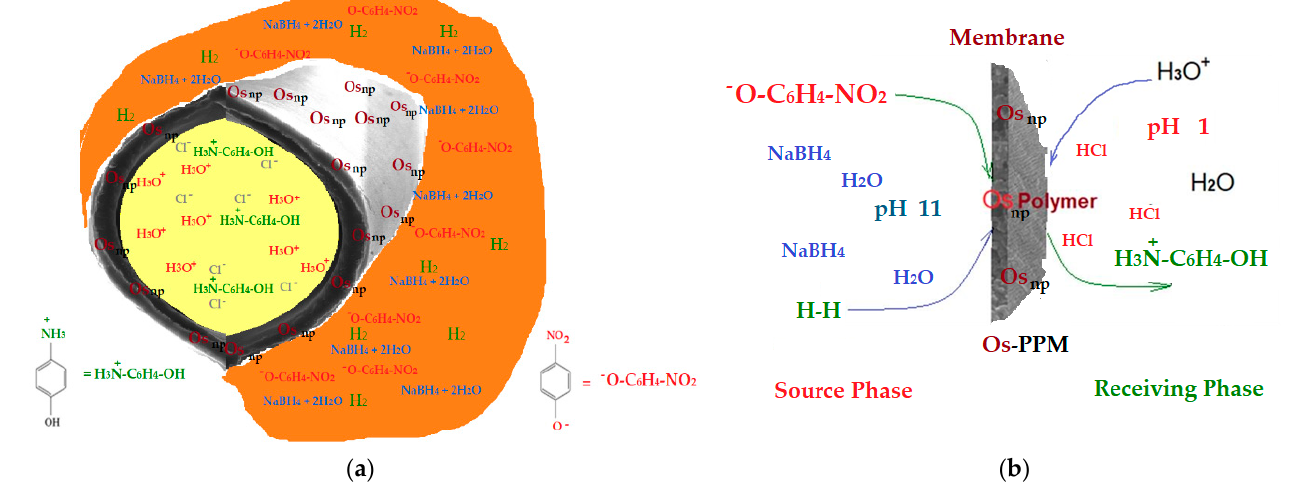
Figure 15. Formal presentation ( a ) and the mechanism of catalytic reduction of p –nitrophenol ( b ).